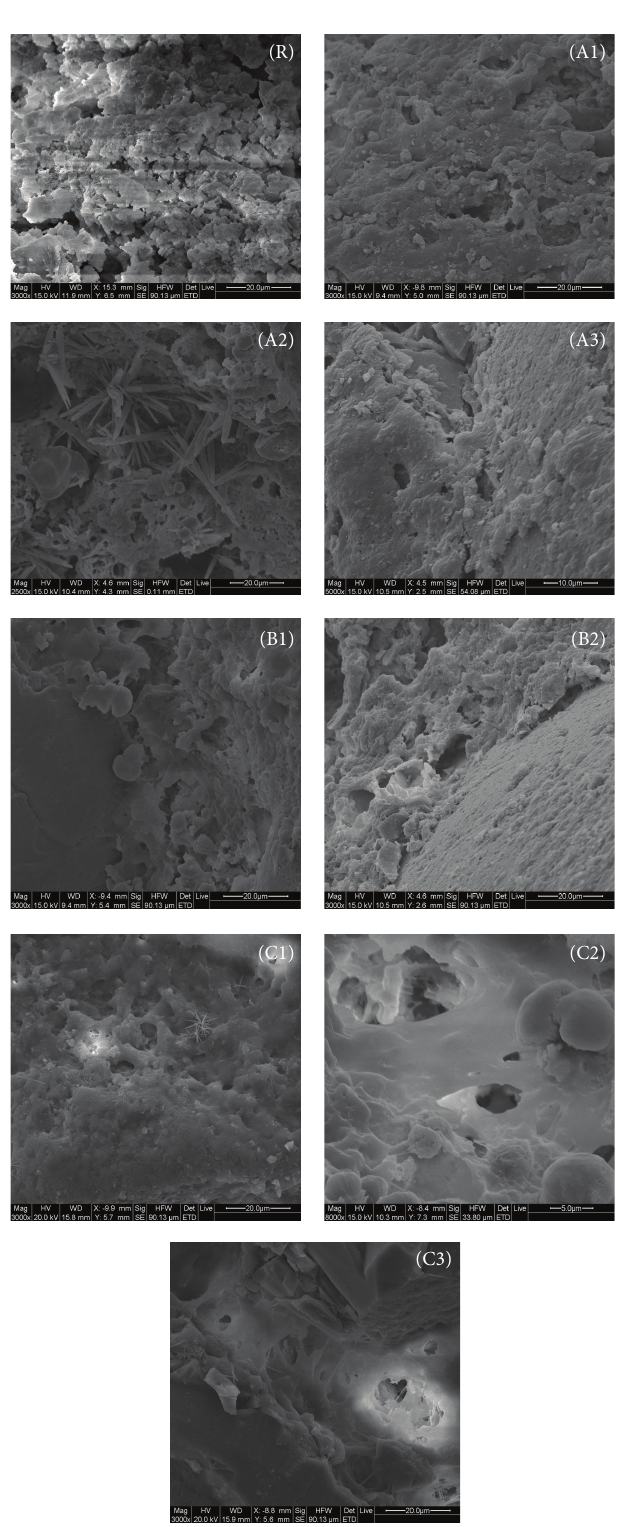
Figure7:Microstructureofrepairmortarsobservedbyscanningelectronmicroscope(SEM).(R)ordinaryrepairmortar;(A1)SBRdispersion formed film in mortar; (A2) SBR film attached on the hydration products; (A3) SBR film attached on the surface of aggregate; (B1) SAE dispersion formed film in mortar; (B2) SAE dispersion film attached on the surface of aggregate; (C1) SAE powder formed film in mortar; (C2) SAE powder film in the hole of mortar; (C3) SAE powder film in the crack of